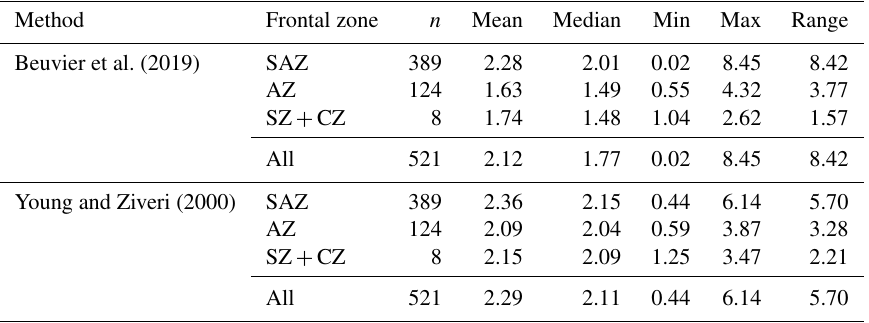
Figure 5. Relative proportions of E. huxleyi morphotypes. Top: morphogroup A. Bottom: morphogroup B. Crosses mark samples where the respective morphotype was not observed. ACC fronts from north to south: NB (Northern Boundary), SAF (Subantarctic Front), PF (Polar Front), SACCF (Southern ACC Front) and SB (Southern Boundary). Table 3. Summary of mass estimations using two different calculation methods: after Beuvier et al. (2019) (Eq. 4) and after Young and Ziveri (2000) (Eq. 5) (all measurements in